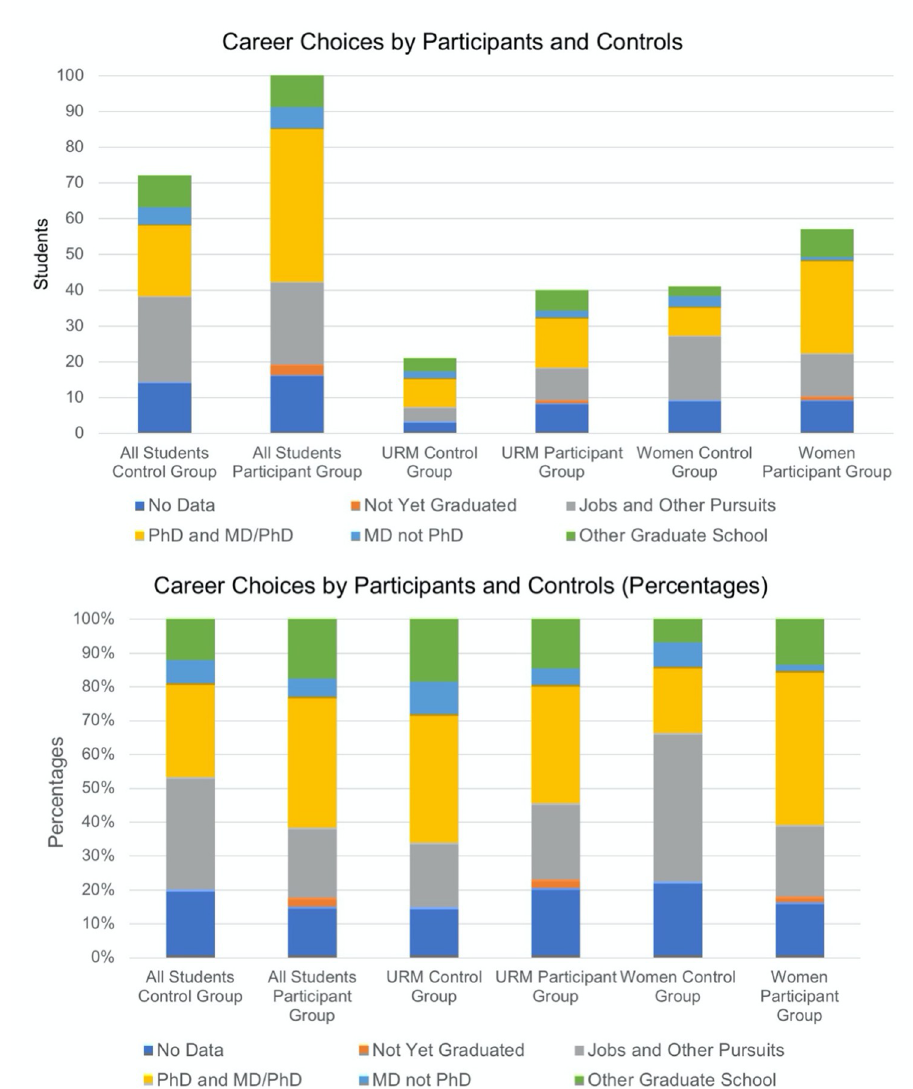
Fig 5. Career choices by participants and controls. Surveys and web-based searches were used to determine the postgraduate plans of BIG Summer participants and a control group composed of students who applied to the BIG Summer program were accepted but did not matriculate. (A) The following data are plotted: the number of students for whom we do not have data, the number of students who have not yet graduated, the number of students enrolled in a PhD or MD/PhD program, the number of students in an MD program, the number of students in another type of graduate school, and the number of students who are employed or engaged in other pursuits. These data are provided for all participants, URM participants and women participants. (B) The same data as in A are shown as percentage of